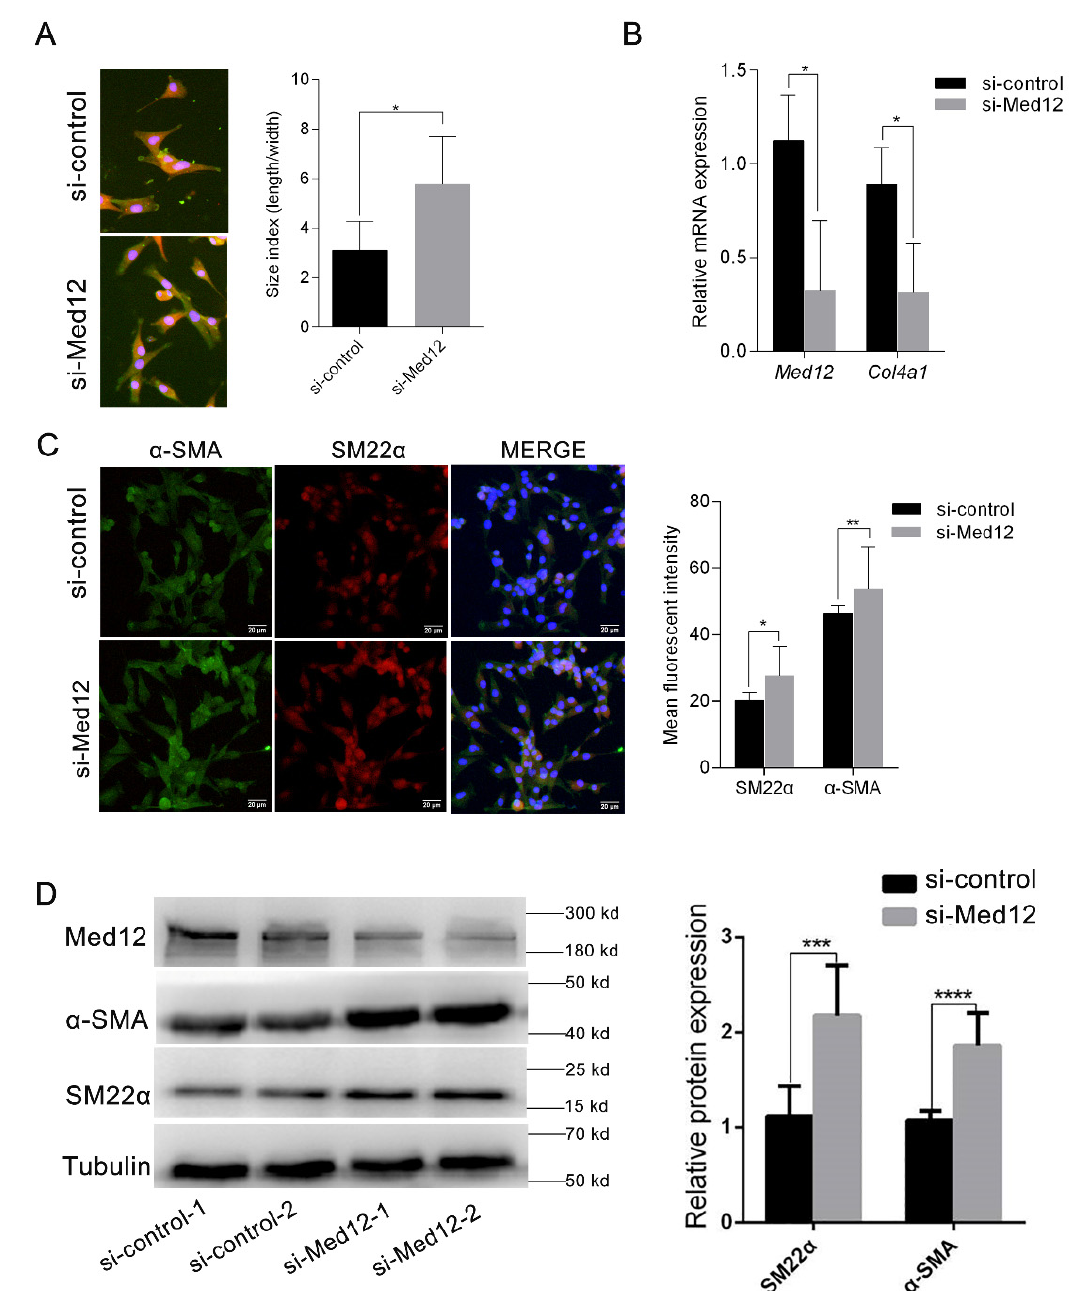
Figure 4. Regulation of cell phenotypic conversion. MOVAS were translated with si-control or si-Med12 for 72 h. ( A ) Fluorescence images were taken using a 40 × objective. The length-to-width ratios of the cells were quantified using ImageJ software. ( B ) Expressions of col4a1 (encoding collagen IV, synthetic VSMC marker) were detected by RT-PCR. ( C ) Immunofluorescent staining for DAPI (blue), α -SMA (green), and SM22 α (red); MERGE represents the combined image of the above three channels. Scale: 20 µ m. Statistics of the mean fluorescence in each visual field (4 visual fields/sample, 3 samples/group). ( D ) The expressions of α -SMA and SM22 α (contractile VSMC marker protein) were detected by Western blot. The experiment was repeated at least three times. Data are expressed as mean ± SD. Statistical analyses, unpaired t -test. * p < 0.05; ** p < 0.01; *** p < 0.001; **** p < 0.0001.